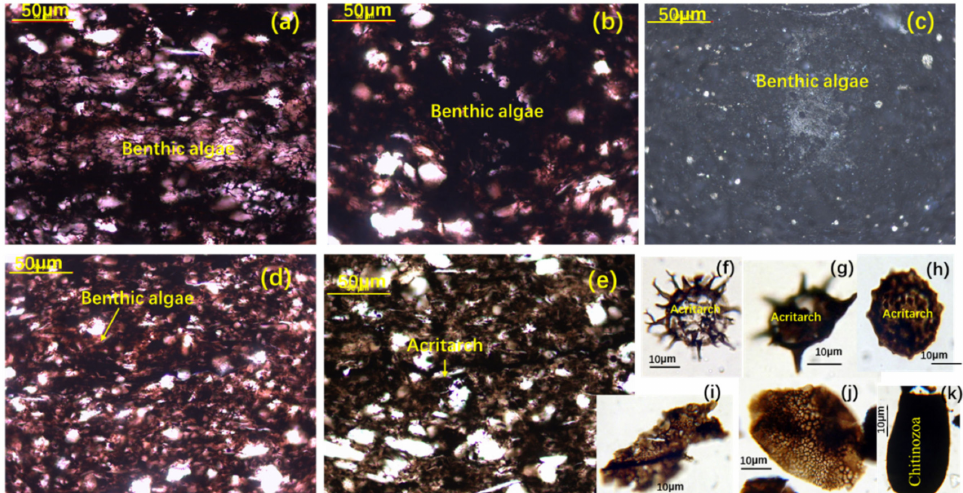
Figure 4. Micro-photos of bio-precursor organic matter. ( a – d ) Debris of multicellular benthic algae, showing multicellular structure of algae. ( e – h ) Acritarch, with ( e ) showing the acritarch in the rocks, while ( f – h ) were acritarchs in the isolated kerogen, including species Multiplicisphaeridium sp ( f ), Goniosphaeridium sp ( g ) and Buedingiisphaeridium sp ( h ). ( i , j ) Multicellular benthic algae debris in the isolated kerogen. ( k ) Chitinozoa in the isolated kerogen. Transmitted polarized light, × 500. Scale bar= 50 µ m ( a – e ), =10 µ m ( f – k ).